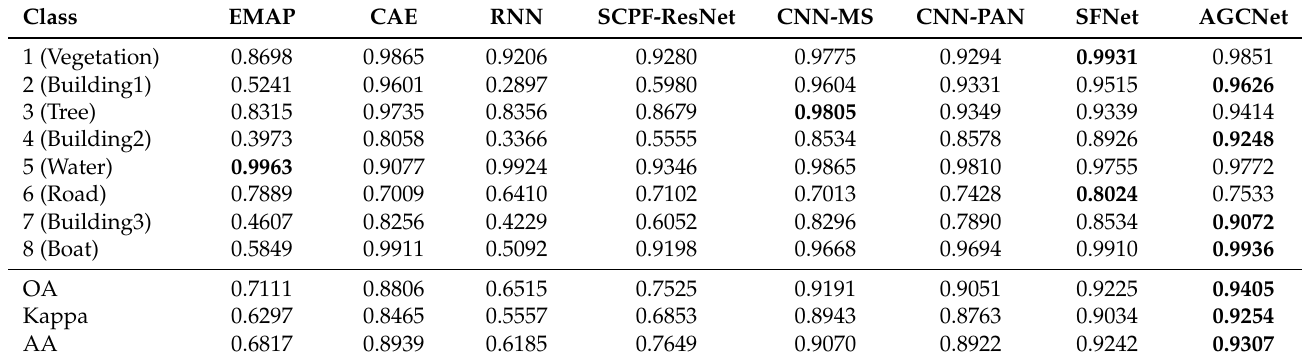
Table 3. Classification accuracy on Level 1C